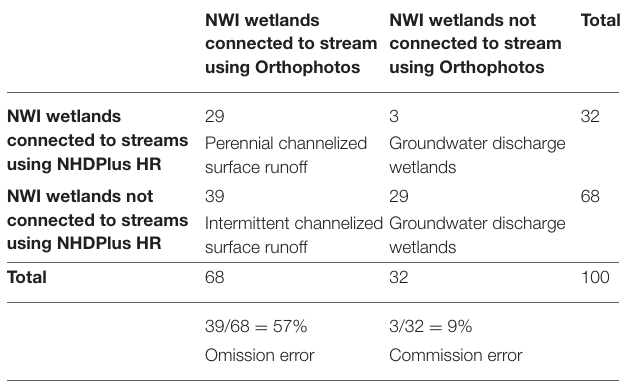
TABLE 2 | Matrix of hydrologic connections of NWI wetlands to streams using 1:300 orthophotography and NHDPlus high resolution (HR) 1:24,000 stream